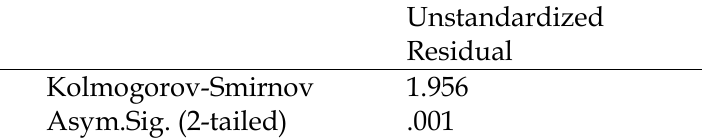
Table 2. Test Result of Kolmogorov